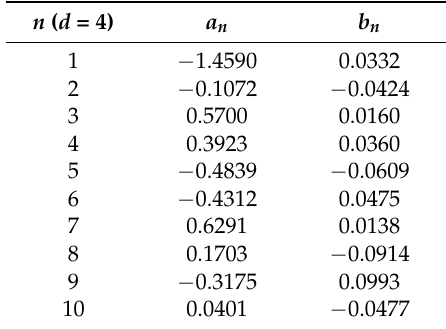
Figure 12. Measured and calculated step responses of the STS system. Table 2. Identified parameters of the transfer function.